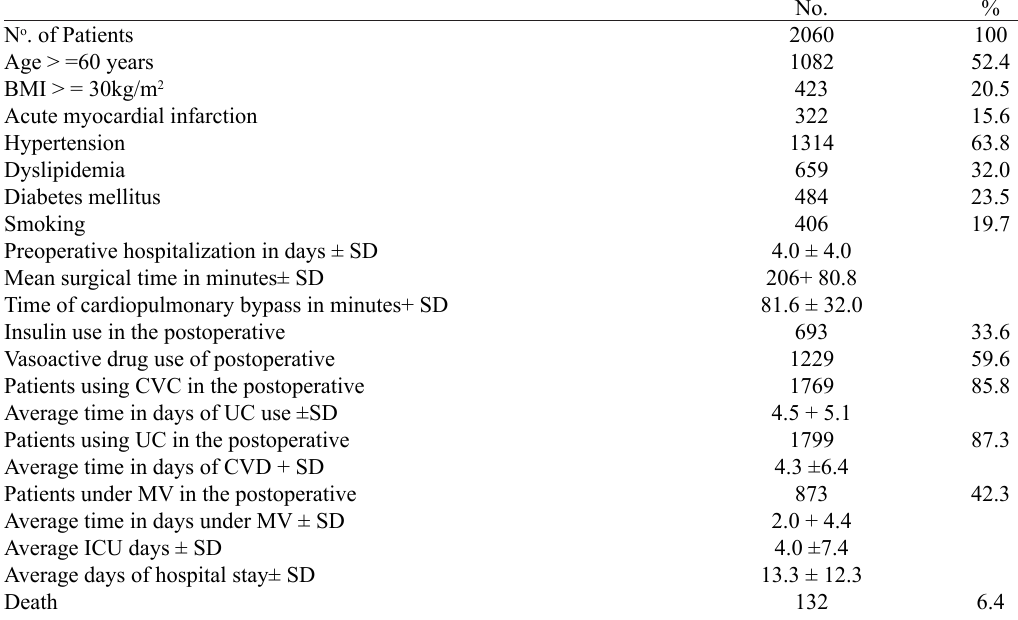
Table 1. Characteristics of patients and procedures performed. N o . of